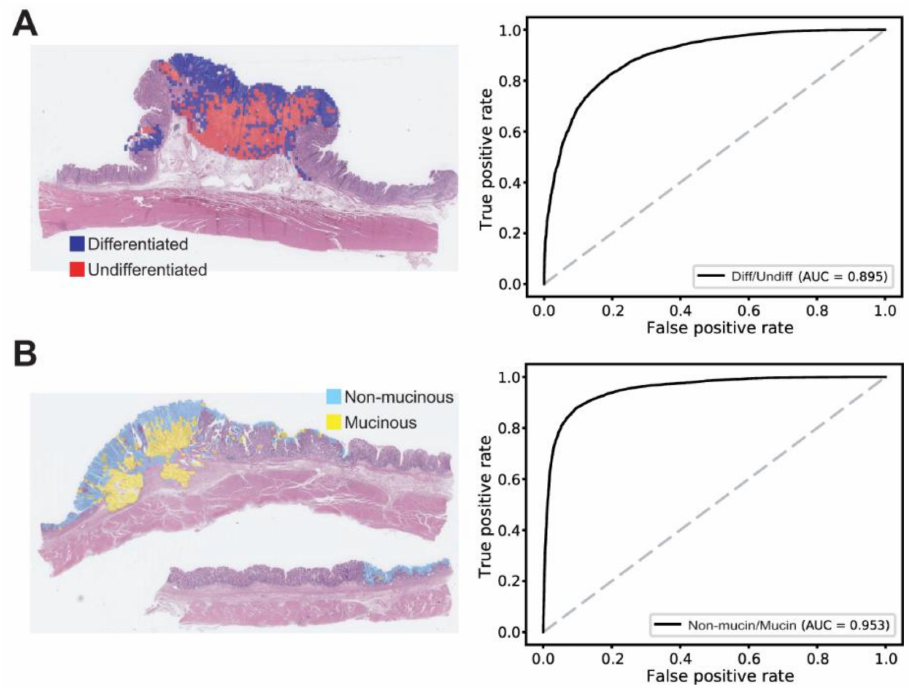
Figure 5. Extra validation of the classifiers trained with the TCGA dataset. ( A ) Classification results of the differentiated/undifferentiated classifier on the SSMH stomach tissues. Left panel: A representative gastric cancer tissue with mixed differentiated/undifferentiated tumor tissues. Right panel: The patch-level area under the curve (AUC) for the receiver operating characteristic (ROC) curve of the differentiated/undifferentiated classifier. ( B ) Classification results of the non- mucinous/mucinous classifier on the SSMH stomach tissues. Left panel: A representative gastric cancer tissue with mixed non-mucinous/mucinous tumor tissues. Right panel: The AUC for the ROC curve of the non-mucinous/mucinous